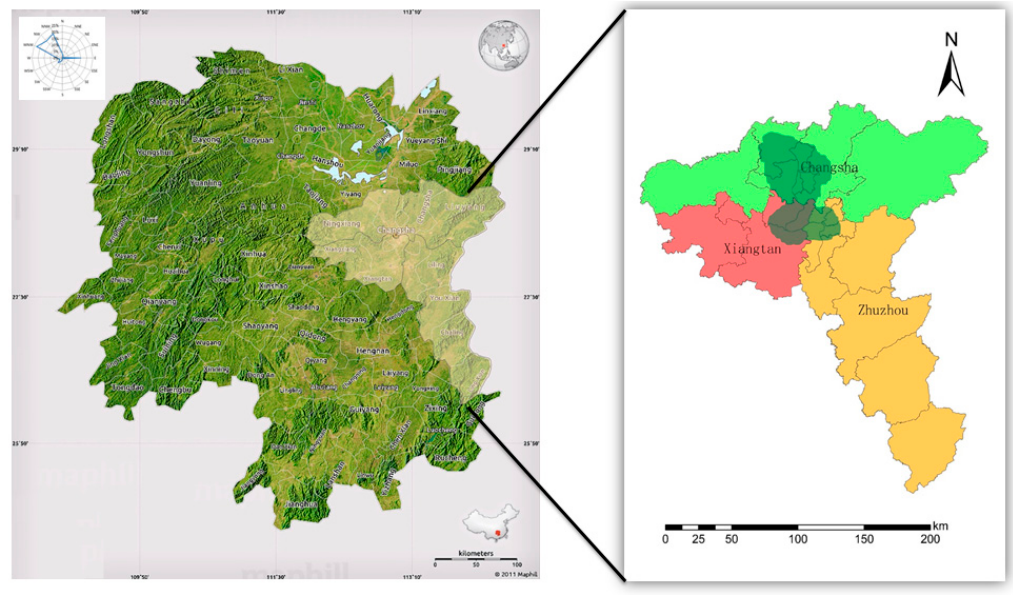
Figure 1. Regional diagram of the Changzhutan urban agglomeration.